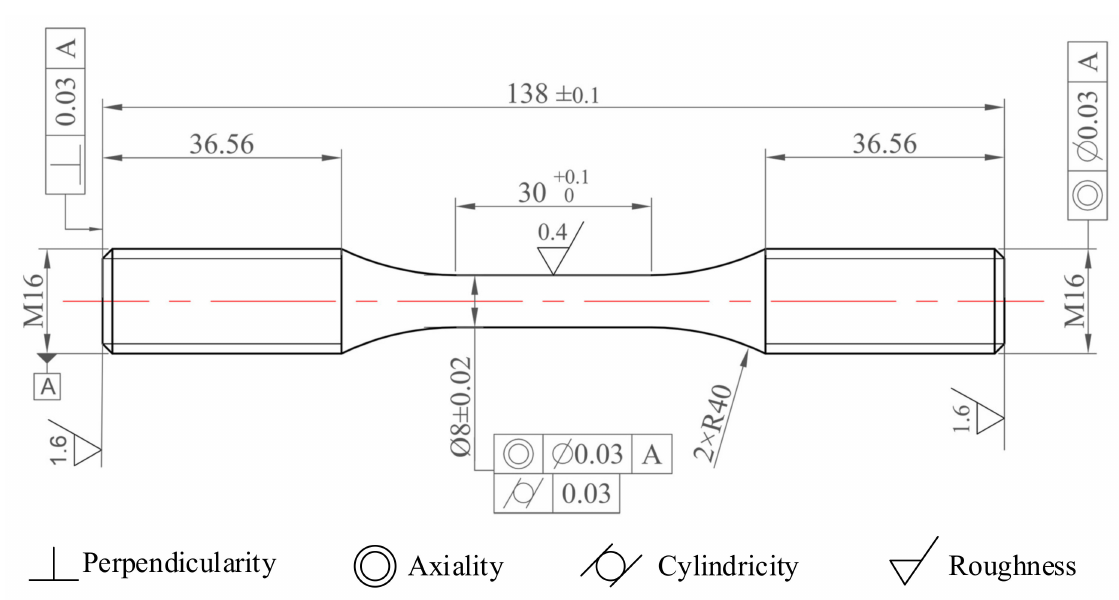
Figure 1. Optical micrograph ( a ) and SEM ( b ) of the solid-solution heat-treated Inconel 625.